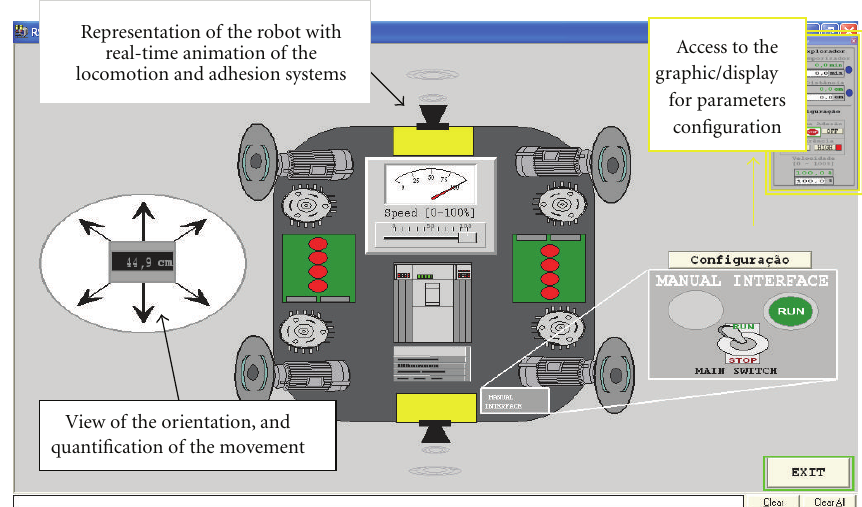
Figure 13: Picture of the graphic/display